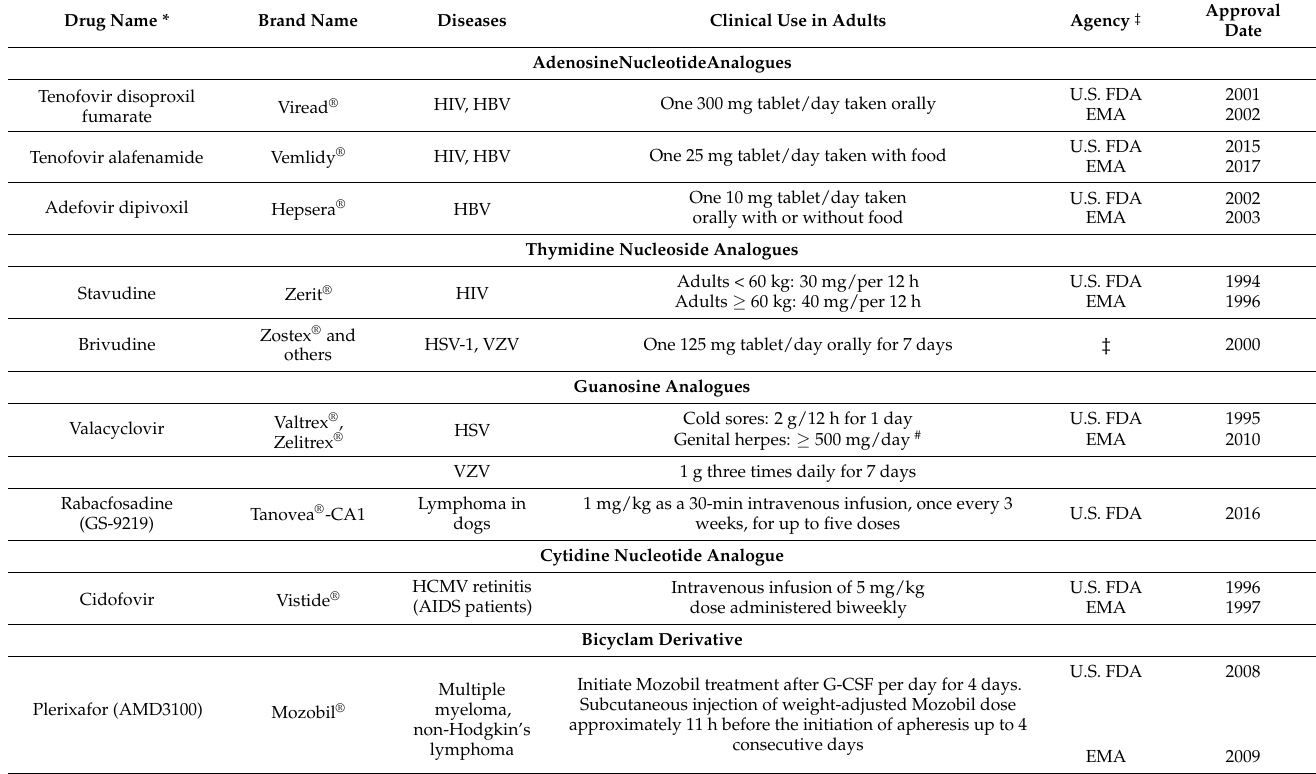
Table 1. A list of approved drugs co-invented by Prof. Erik De